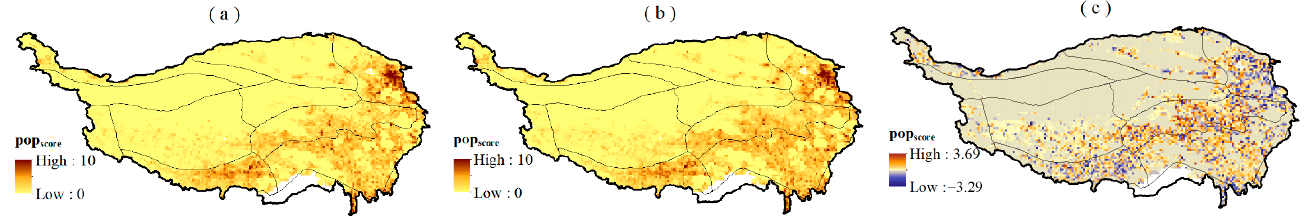
Figure 12. Spatial distribution of the population density scores in 2000 ( a ) and 2015 ( b ) and their differences ( c ).